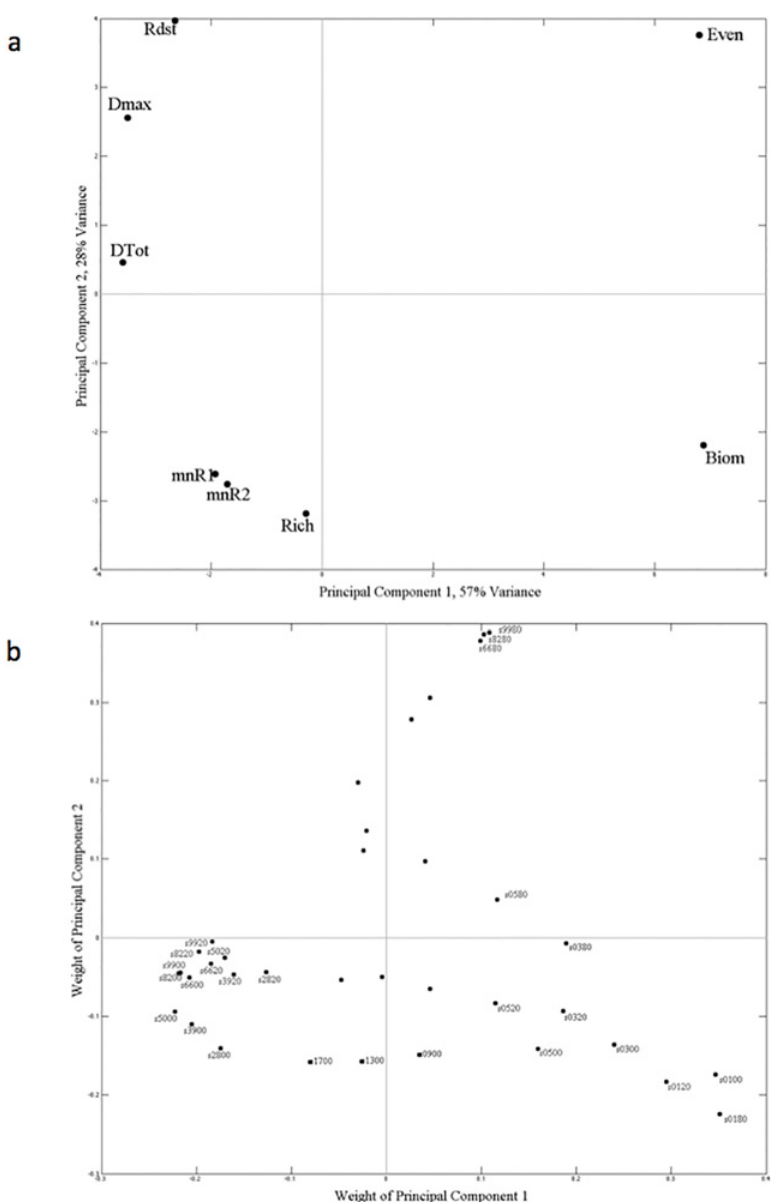
Fig 5. Principal component analysis using all simulations where the transitions in resource supply concentration were sudden. Parameter weightings (a) and the simulation scenario weightings (b) on the two principal components with the greatest eigenvalues, PC1 and PC2, represented 57% and 28%, respectively, of the total variability. Parameters in the analysis were timer-averaged richness ( ‘ Rich ’ ), evenness ( ‘ Even ’ ), biomass ‘ (Biom ’ ), overyielding ( ‘ Dmax ’ ), species interactions ( ‘ DTot ’ ), length of the resource trade-off curve exploited ( ‘ Rdst ’ ), and drawdown of resources one and two ( ‘ mnR1 ’ and ‘ mnR2 ’ ). Simulation scenarios are identified using a numbering scheme where the first two digits identify the level of complementarity ( ‘ 99 ’ lowest level, ‘ 01 ’ highest level) and the second two digits identify the level of noise in the resource supply concentrations ( ‘ 00 ’ means no noise, ‘ 20 ’ means 0 to 20% noise, and ‘ 80 ’ means 0 to 80%